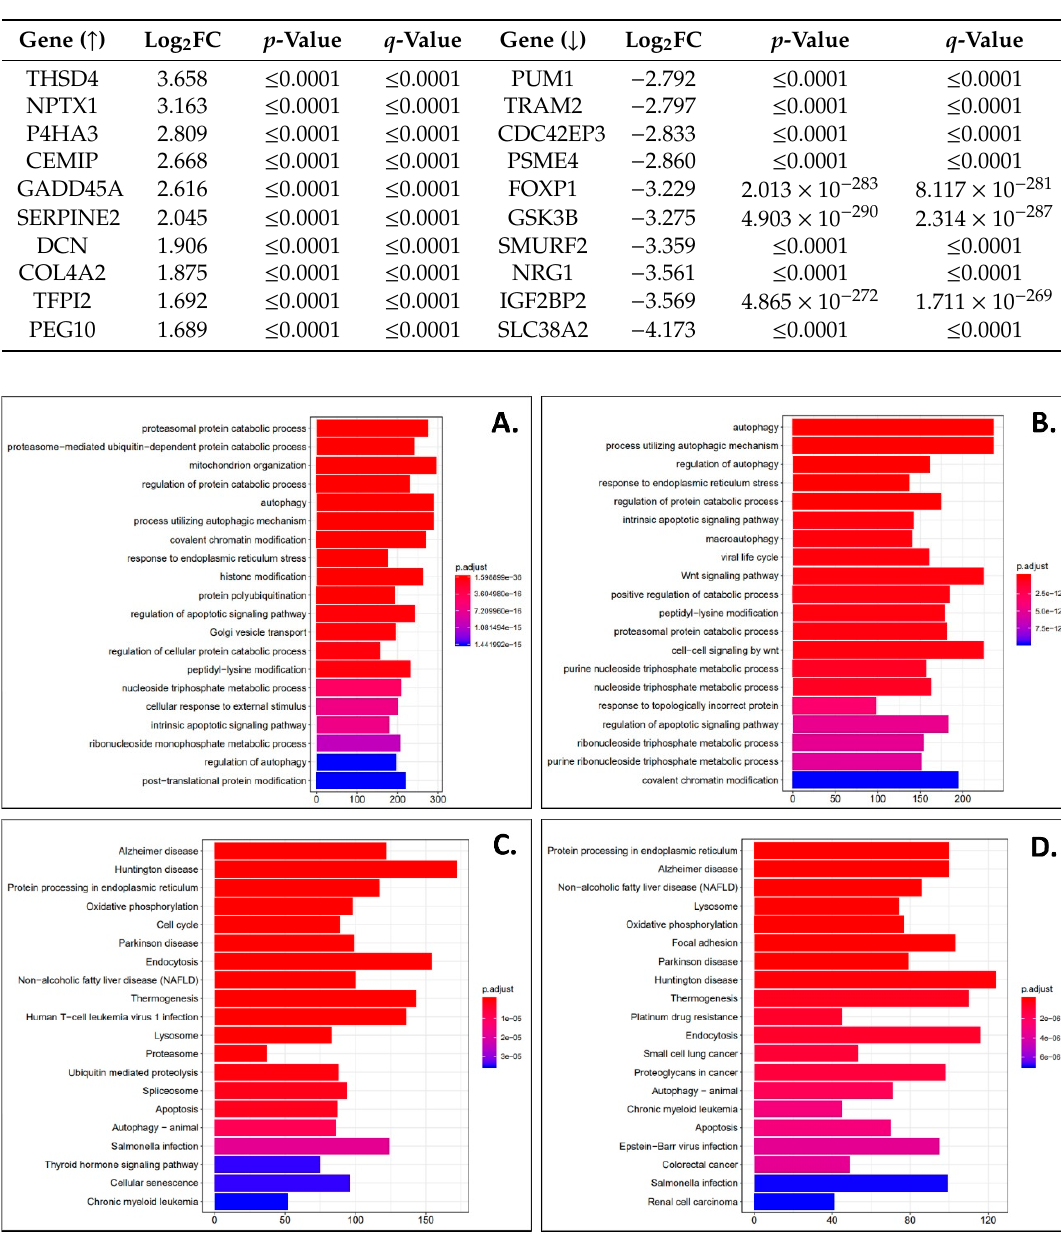
Figure 6. Comparative analysis of cellular pathway modulation between phenanthriplatin and cisplatin treatments in A549 and IMR90 cells. ( A ) The top 20 enriched GO biological processes for the A549 phenanthriplatin versus A549 cisplatin comparison. ( B ) The top 20 enriched GO biological processes for the IMR90 phenanthriplatin versus IMR90 cisplatin comparison. ( C ) The top 20 enriched KEGG pathways for the A549 phenanthriplatin versus A549 cisplatin comparison. ( D ) The top 20 enriched KEGG pathways for the IMR90 phenanthriplatin versus IMR90 cisplatin comparison. The x-axes show the number of DEGs per GO biological process. Statistical analysis for KEGG pathway analysis is provided in the panels.